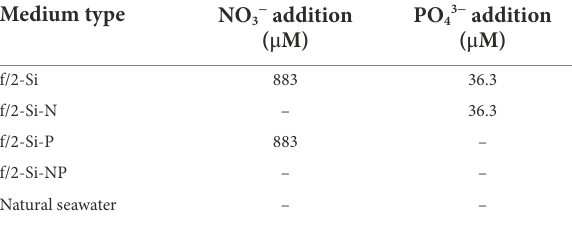
TABLE 1 Laboratory setting of different nutritional conditions for growth of Akashiwo sanguinea . Medium